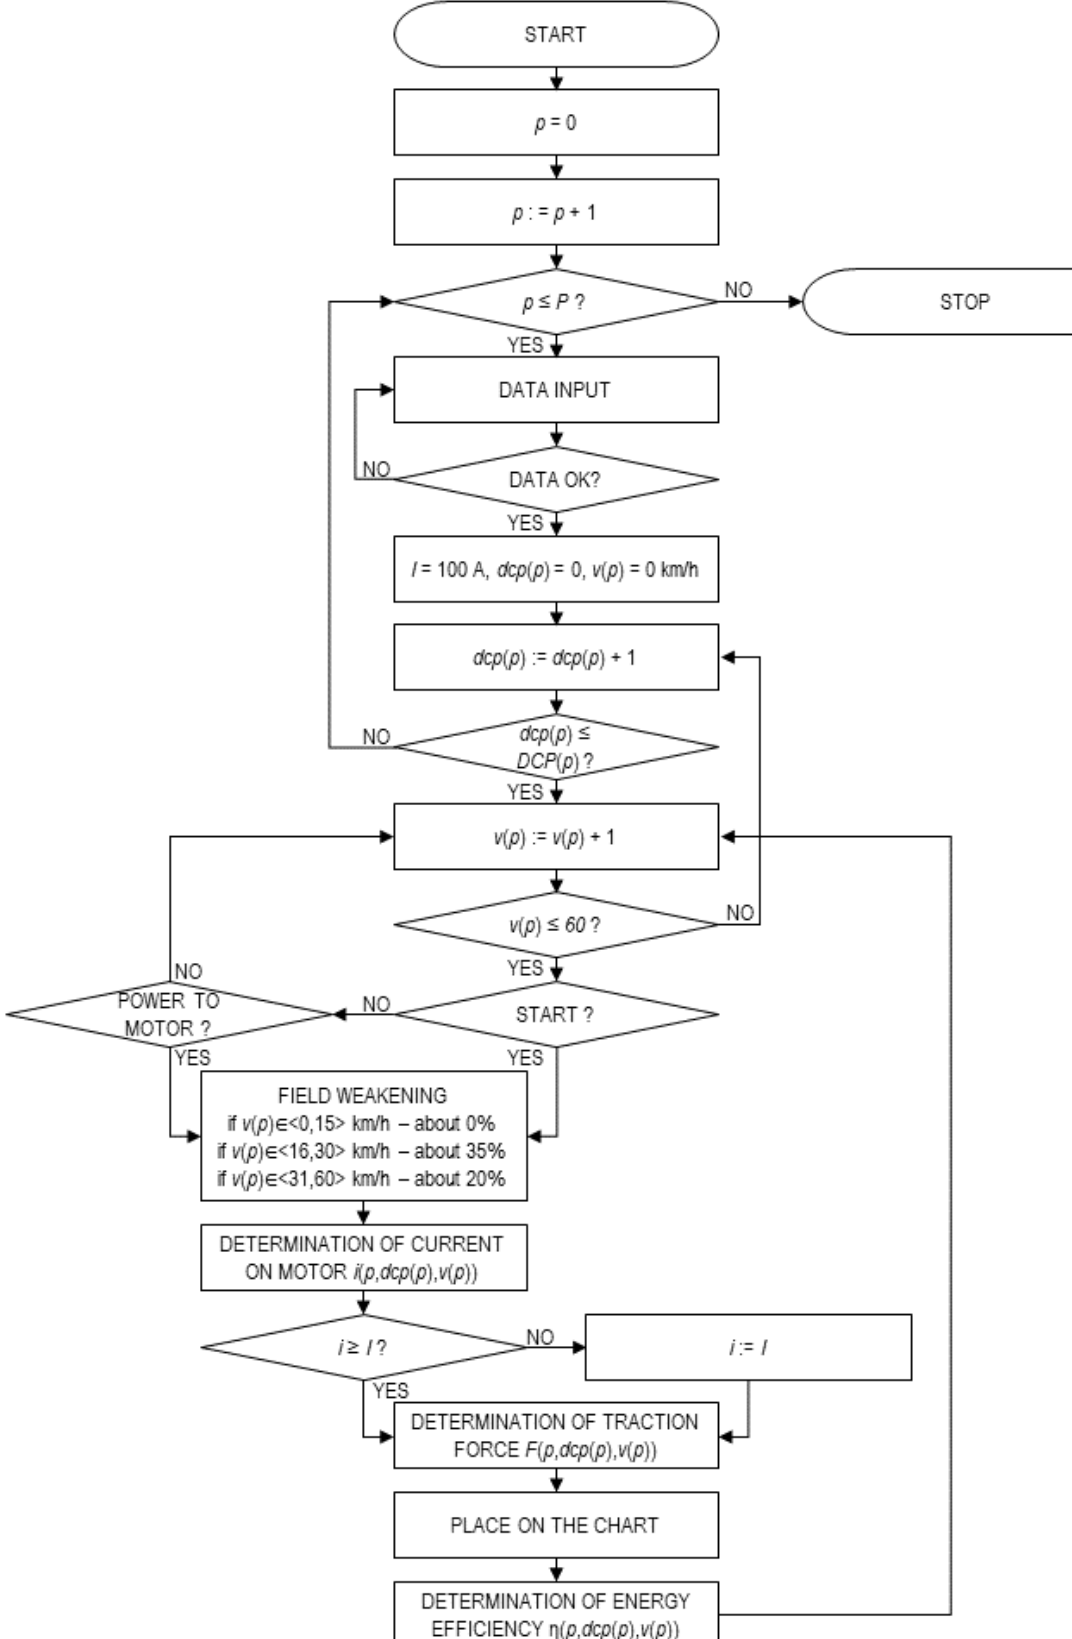
Figure 3. Author’s method of developing the traction characteristics of a vehicle equipped with an electric DC traction motor and determining the engine’s energy efficiency. Source: own work.